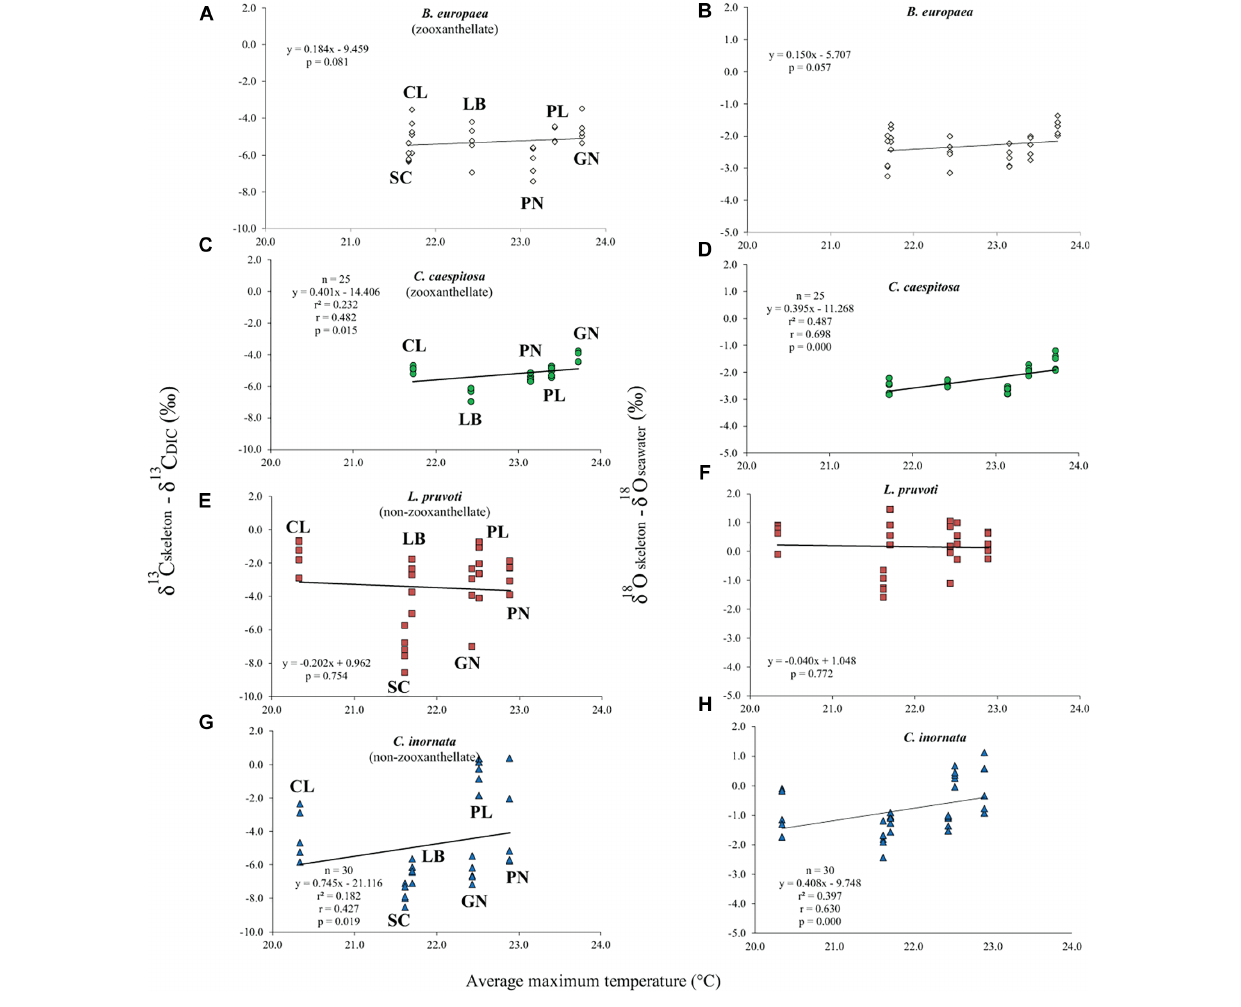
FIGURE 6 | The relation between skeletal δ 13 C and δ 18 O with average maximum temperature in B. europaea (temperature at 6 m; A,B ), C. caespitosa (temperature at 6 m; C,D ), L. pruvoti (temperature at 16 m; E,F ), and C. inornata (temperature at 16 m; G,H ). r 2 , Spearman’s determination coefficient; r , Spearman’s correlation coefficient; n , number of